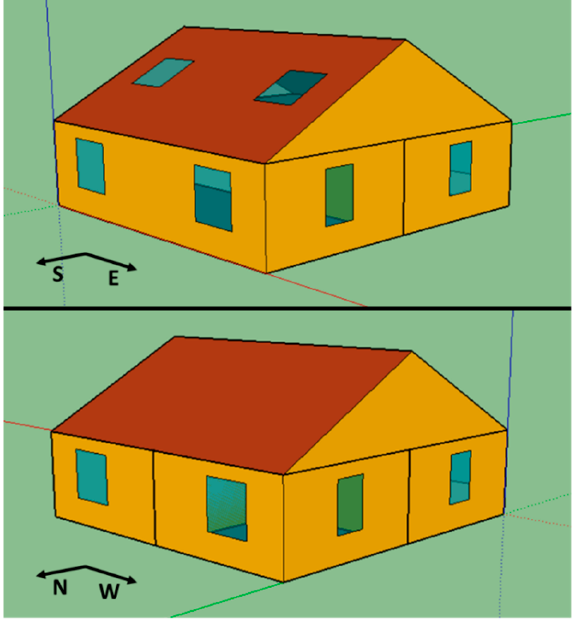
Figure 2. Structure of the case study building. Table 2. Building elements reference transmittances [44].